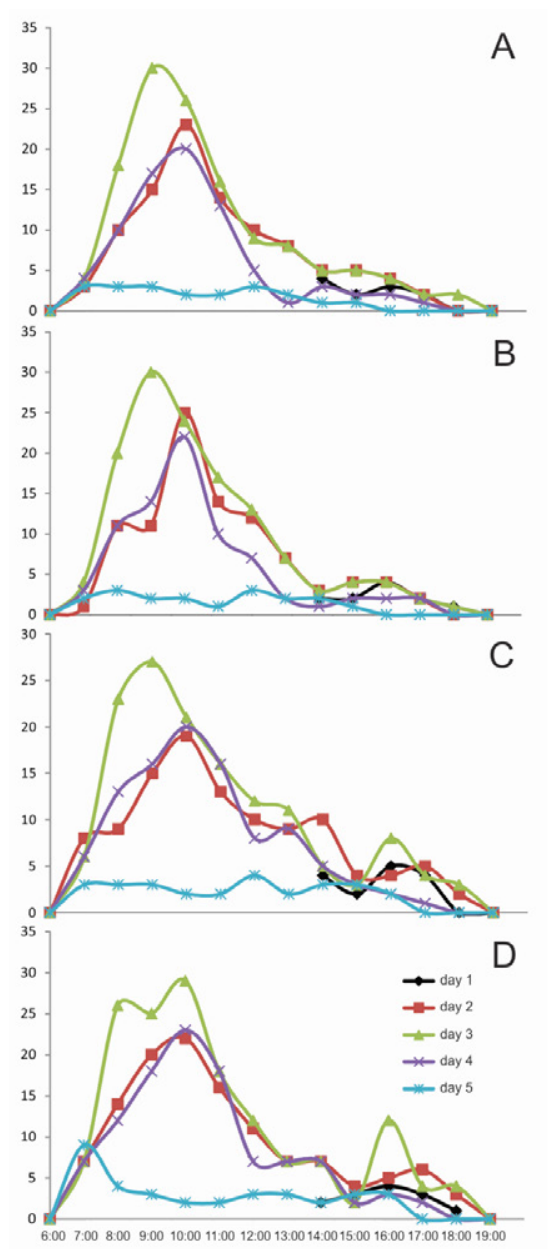
Fig 1 . Flight activity of Melipona fuliginosa during the robbing of an Melipona paraensis colony. (A) M. fuliginosa workers entering the M. paraensis colony. (B) M. fuliginosa workers leaving the M. paraensis colony. (C) Workers leaving the M. fuliginosa colony. (D) Workers returning to the M. fuliginosa colony. There were no statistical differences among A, B, C and D (H(3) = 3.63–0.50, p >